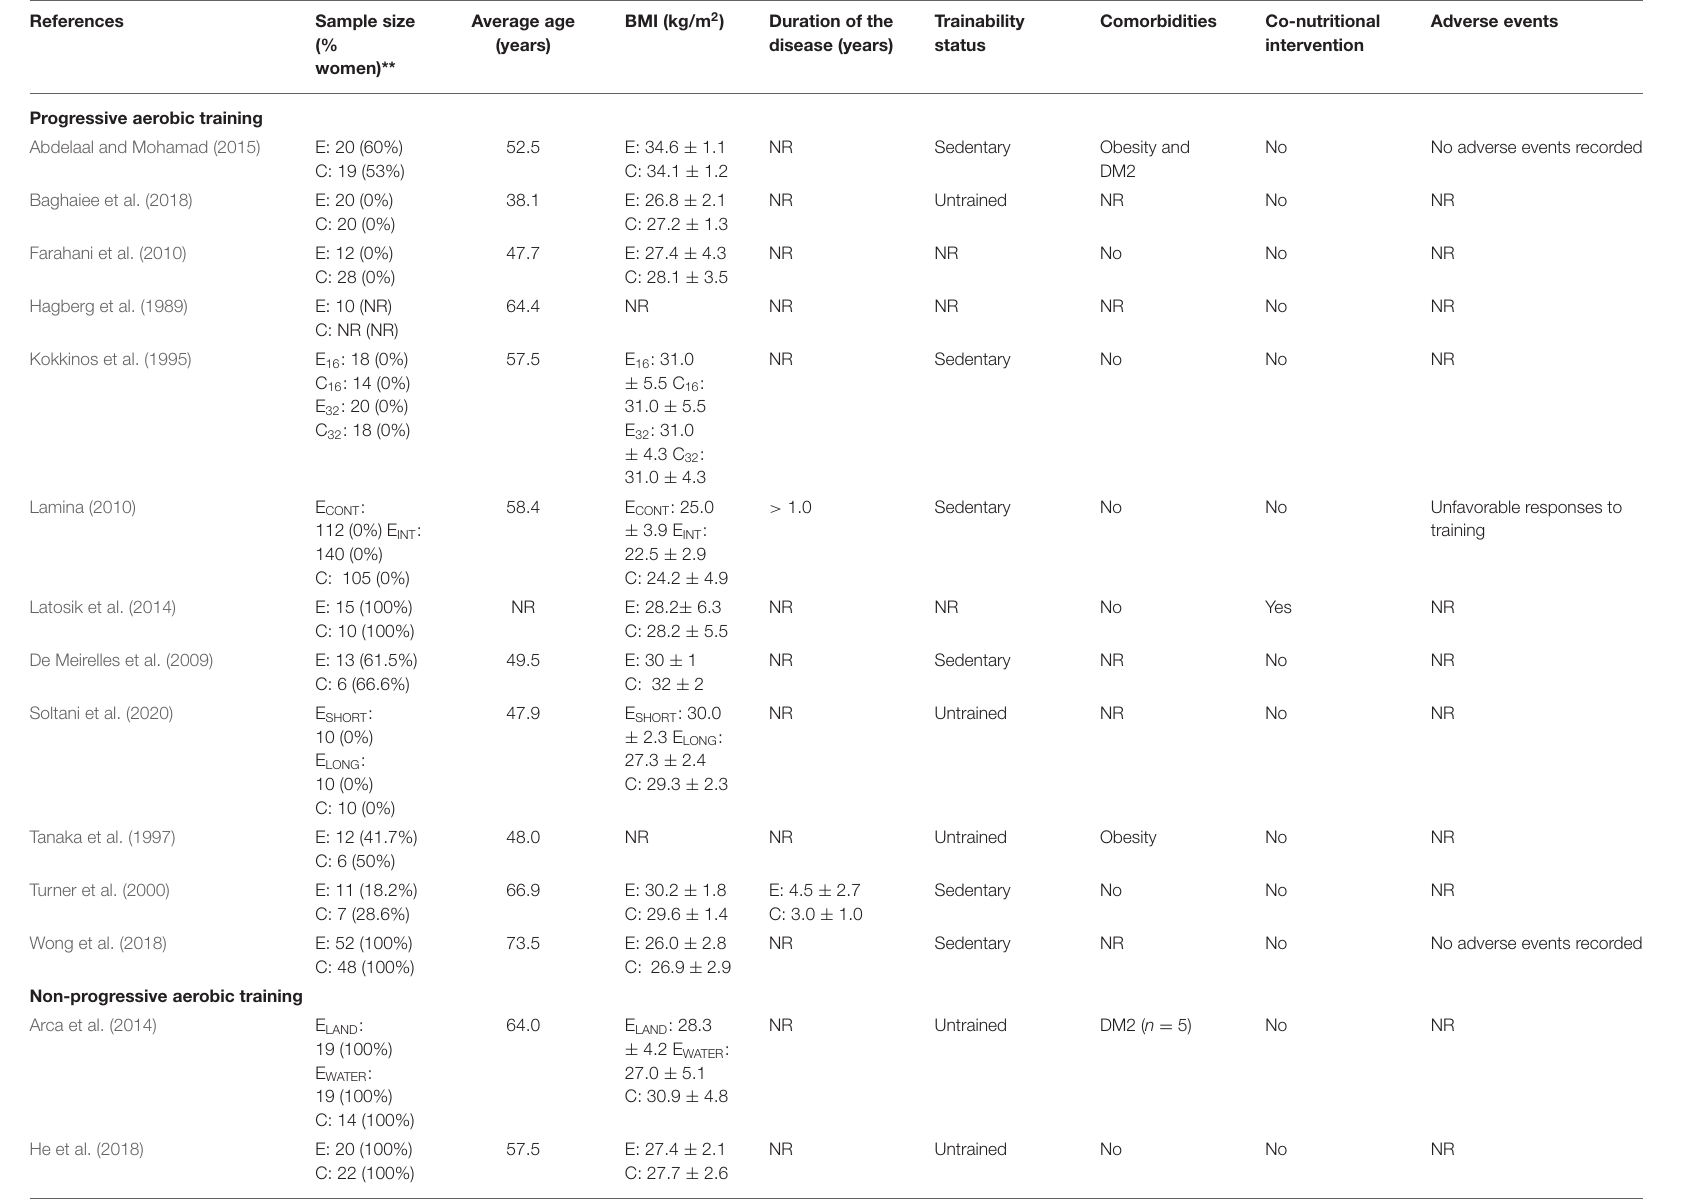
TABLE 1 | Characteristics of the